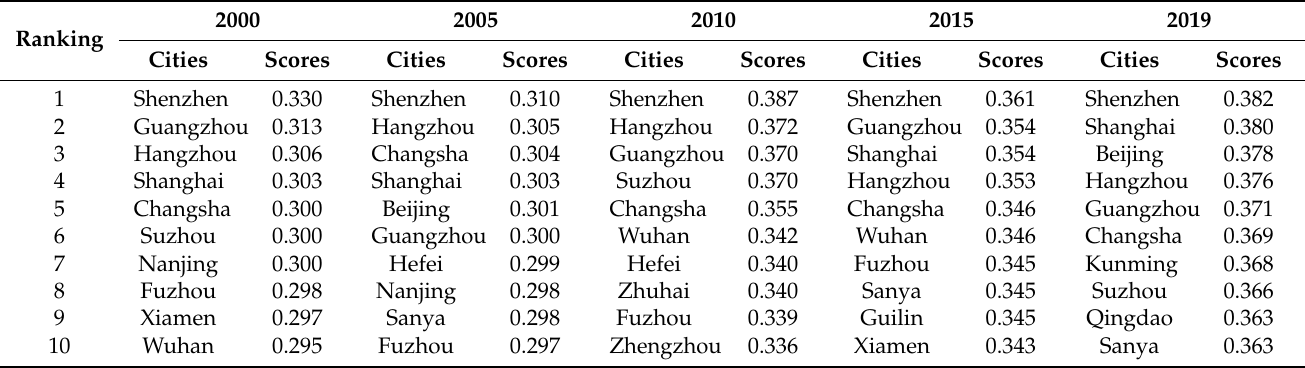
Table 2. The top ten cities in China’s urban human settlements development level and their scores. Ranking